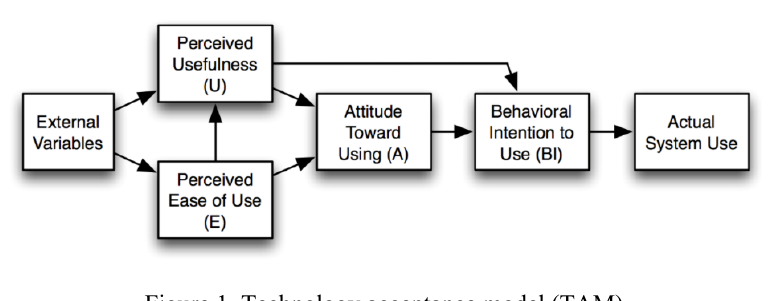
Figure 1. Technology acceptance model